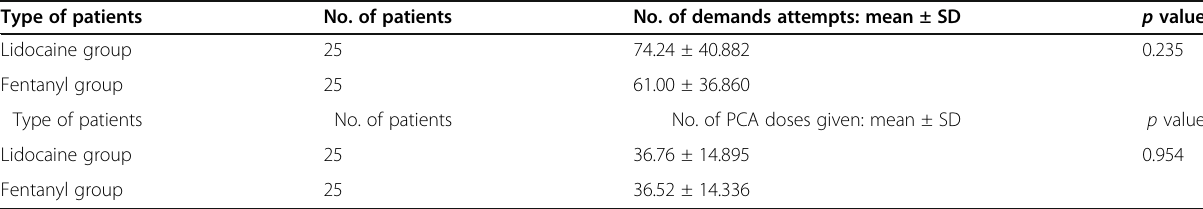
Table 2 First 24 h demand of postoperative controlled analgesia (PCA) Type of patients